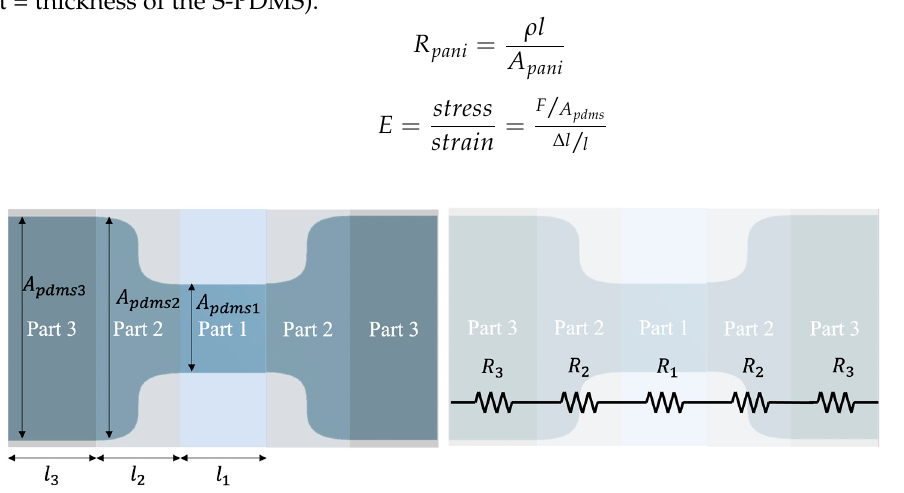
Figure 5. An equivalent circuit model of dumbbell shape.